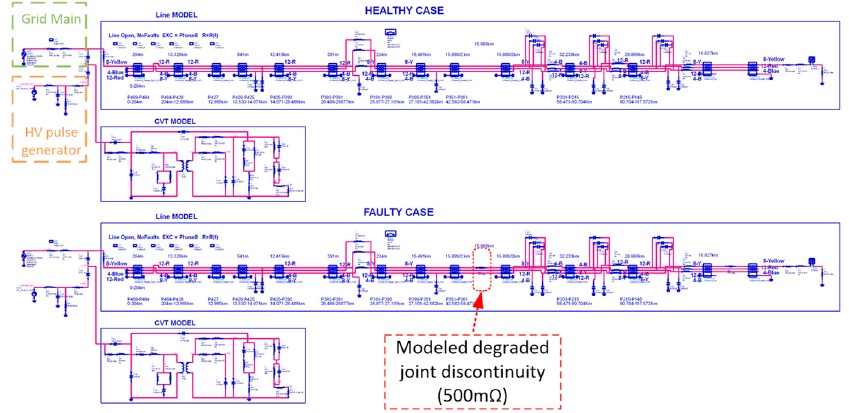
Figure 13. Schematic implementation in Keysight ADS of Scenario#1.